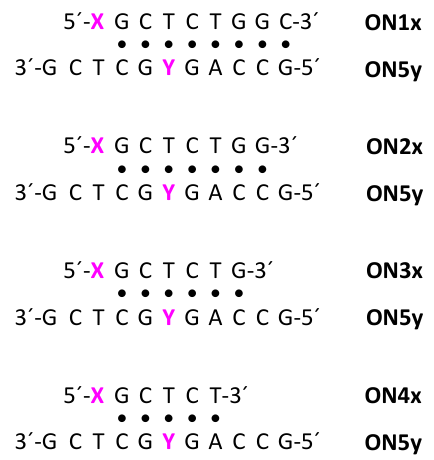
Figure 1. Outline of the hybridization assays used. X is either adenine or unmetalated or cyclopalladated benzylamine and Y is any canonical nucleobase. The bullets indicate Watson-Crick base pairing.